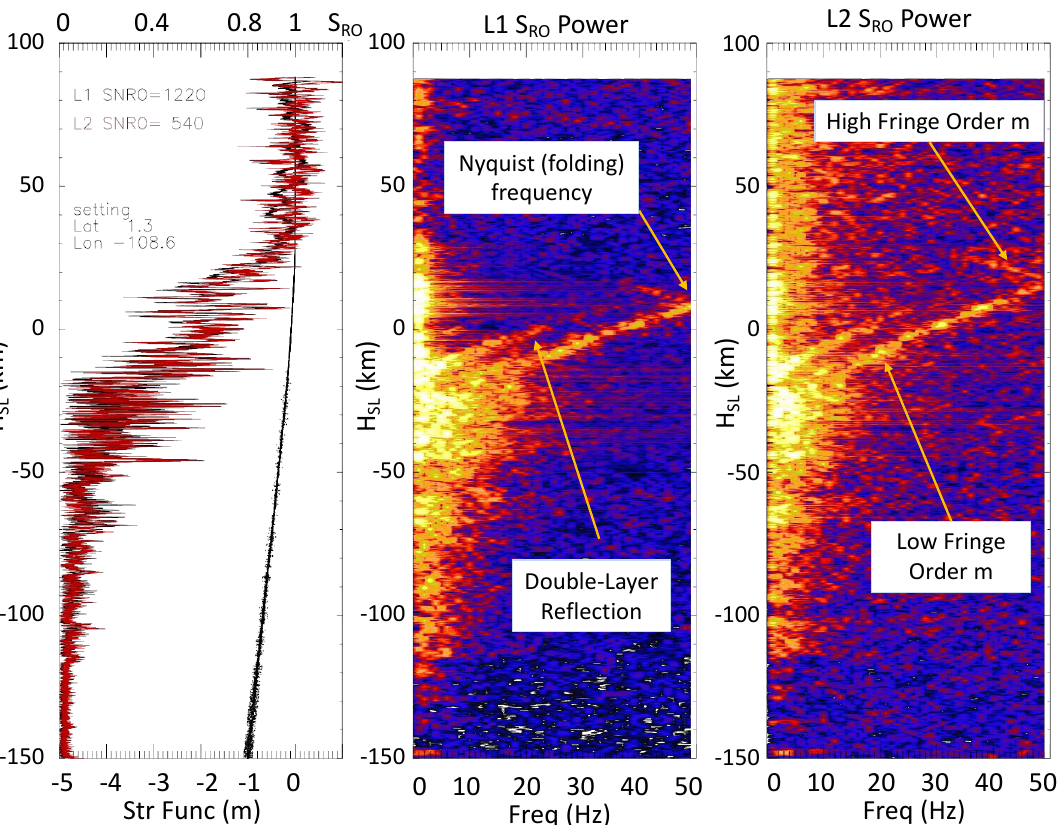
Figure A8. As in Figure A5 but for double-layer reflection from a COSMIC-2 grazing angle RO on 11 April 2021 at (1.3° N, 103.6° E), where the reflection feature is evident in both L1 and L2 S RO power spectrum profiles.